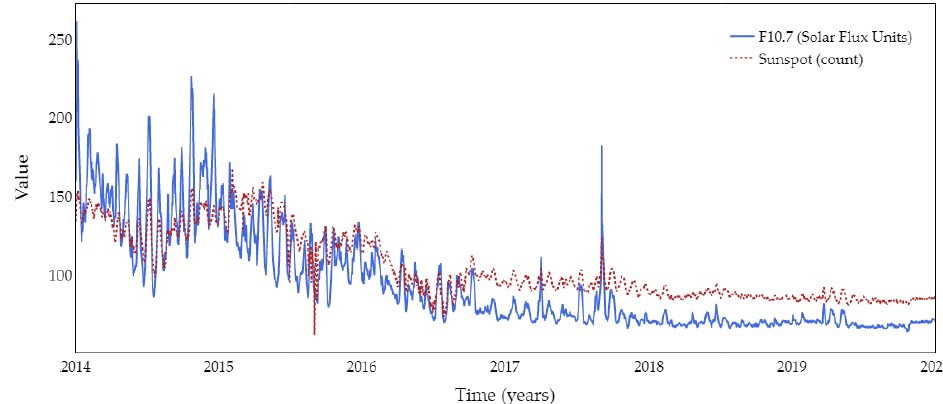
Figure 1. Variation of F10.7 and sunspot number from 2014 to 2020.